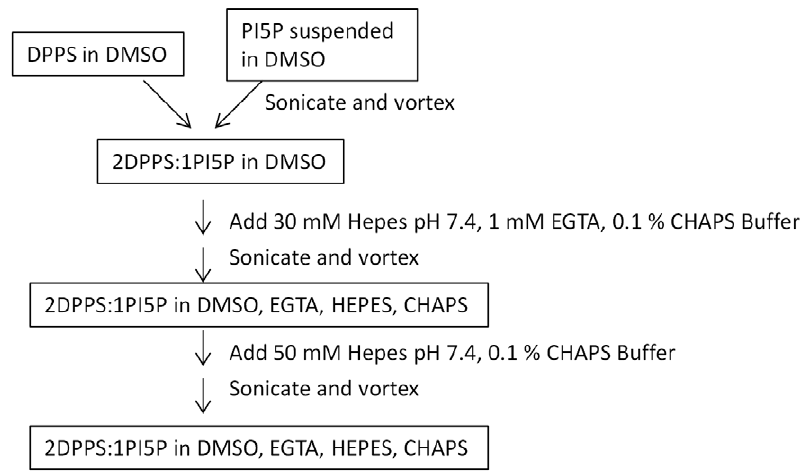
Figure 2. Schematic representation of the 2:1 DPPS:PI5P lipid preparation protocol.